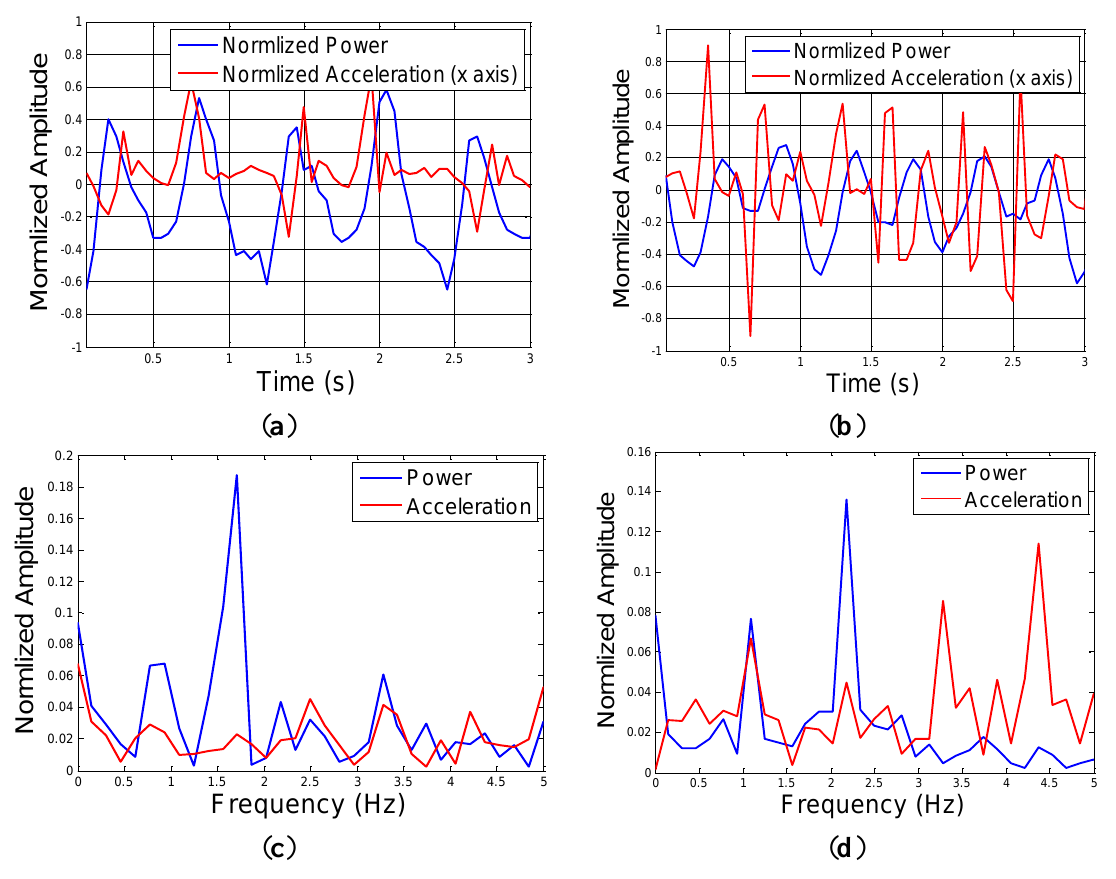
Figure 7. RSSI patterns of walking ( a ) and running in time ( b ) and walking ( c ) and running ( d ) in spectrum. Both RSSI and acceleration patterns have periodical pattern with a period equal to gait cycle time, but the RSSI estimations are less